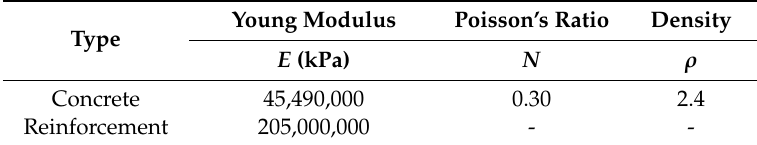
Figure 9. Details of the part of the reactor building in the high-fidelity analysis model; solid elements are used for the part of concrete and shell elements are used for the part of reinforcement. Table 1. Deformation characteristic parameters of the reactor building used for the simulation